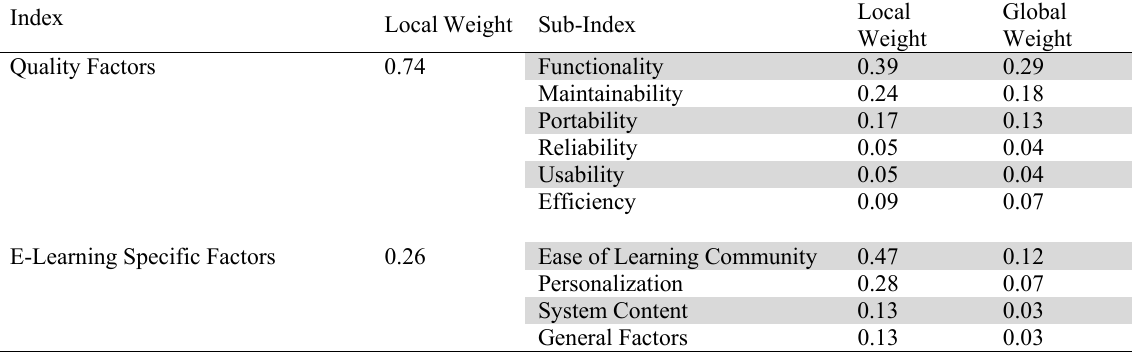
Weights of E-learning websites selection index by FAHP Index Quality Factors